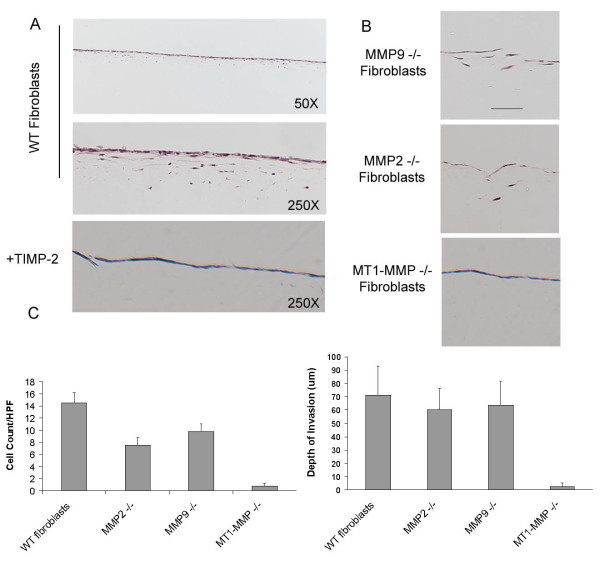
MT1-MMP deficient fibroblasts demonstrate reduced invasion into type I collagen gels. Wild-type (WT) murine fibroblasts derived from the dermis of late-gestation embryos were cultured atop collagen and invasion assessed over a 6 day period in the presence or absence of TIMP-2 (10 nM) added to the culture daily (A). MMP-2 -/- and MMP-9 -/-, but not MT1-MMP -/- cells penetrate type I collagen over the 6 day culture period normalized for total cell number (B); the results are quantified by number of cells invading and depth of penetration (C). Experiments were conducted in DMEM with 10% WT, MMP-2 null or MMP-9 null serum. (Magnification as marked, bar = 100 μm)